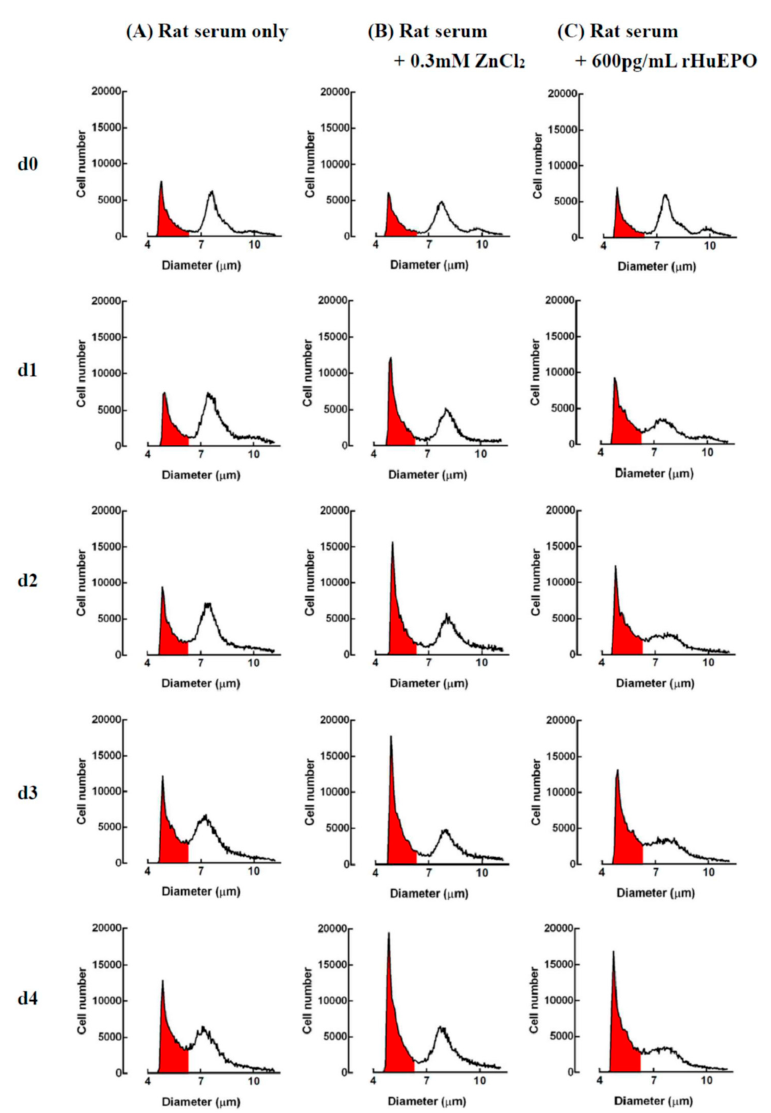
Figure 6. Representative profile of rat bone marrow cell suspensions cultured with ( A ) rat serum only, ( B ) 0.3 mM ZnCl 2 + rat serum, and ( C ) 600 pg/mL rHuEPO + rat serum. After 1, 2, 3, and 4 days